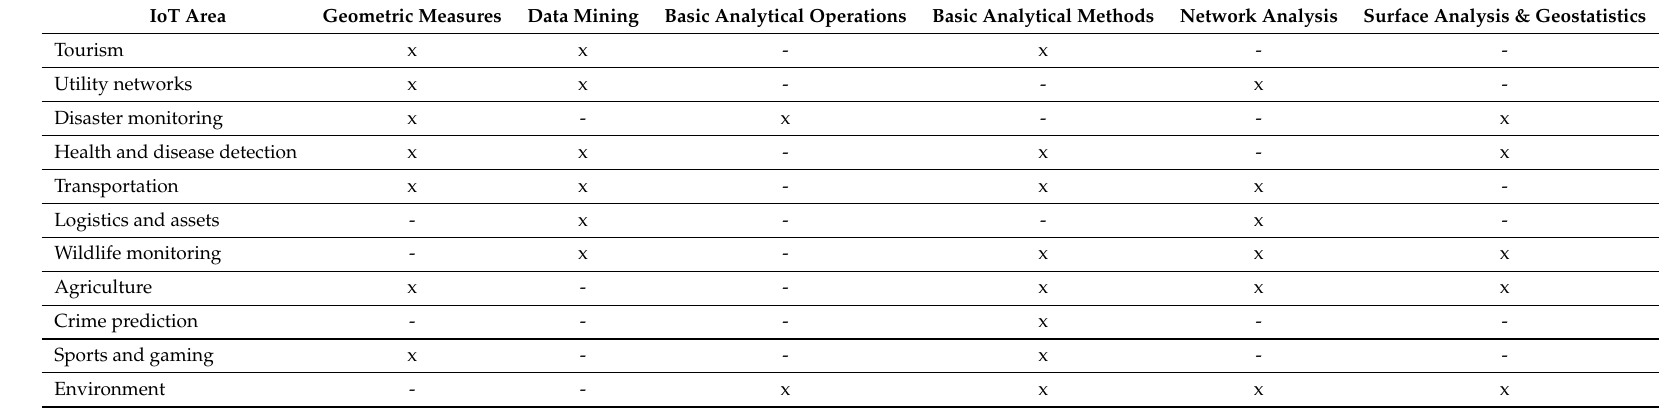
Table 1. IoT research areas and geospatial analytical